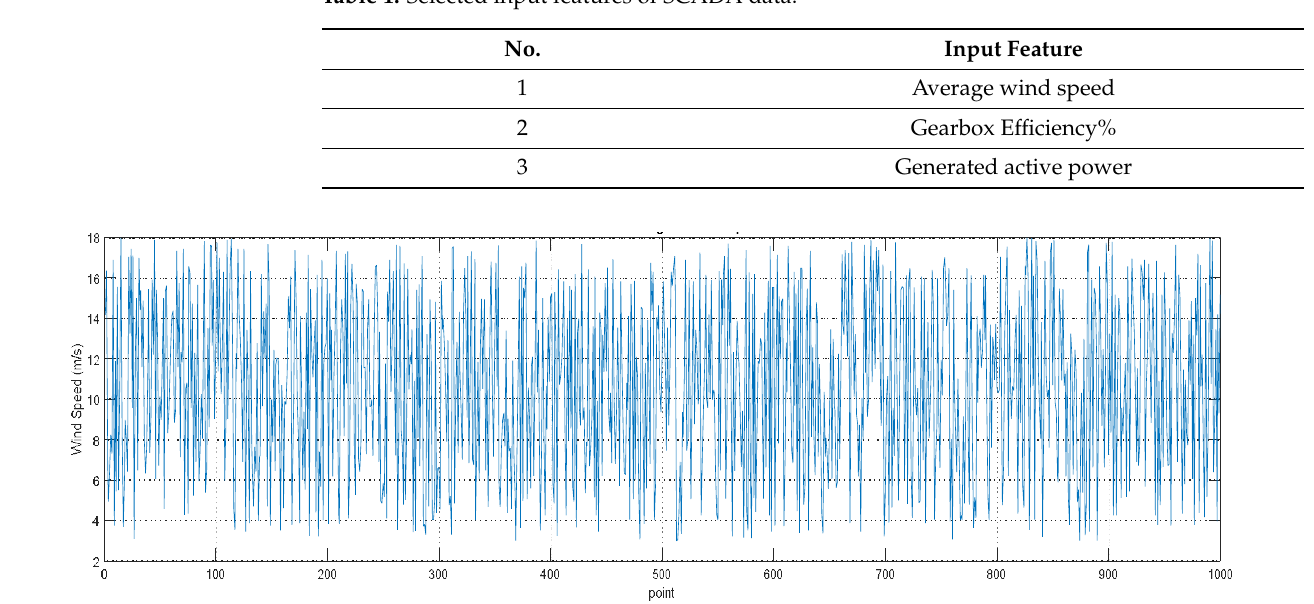
Table 1. Selected input features of SCADA data.